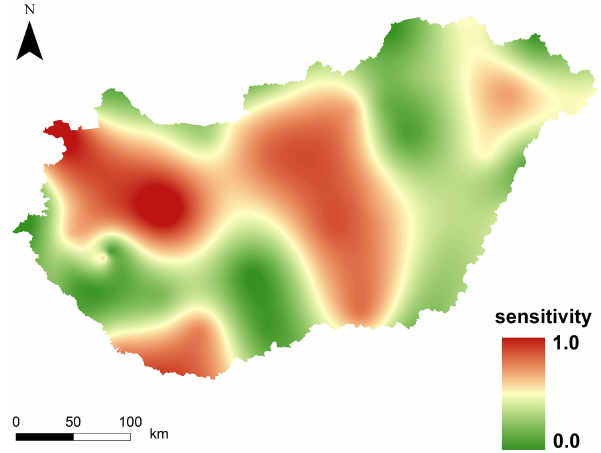
Figure 11. Sensitivity of the areas in response to the occurrence of erosive